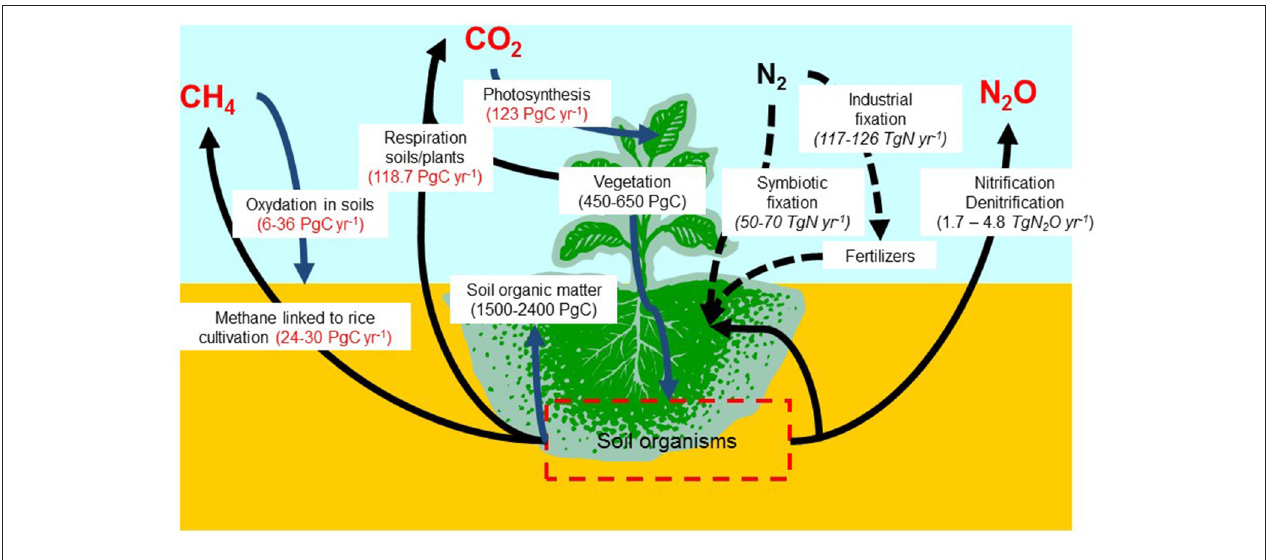
FIGURE 1 | Soil and GHGs fluxes (adapted from Ciais et al.,